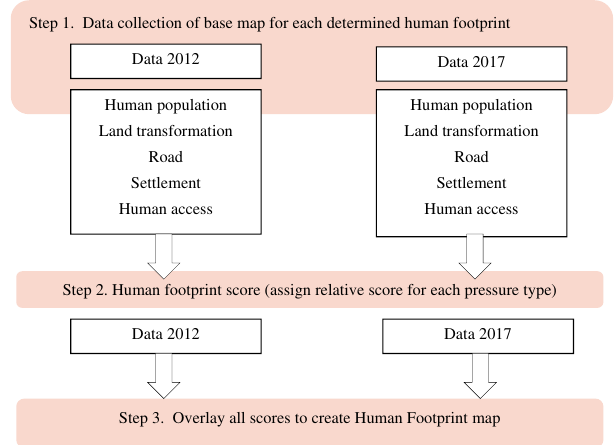
Figure 7. Flowchart showing the process of mapping the Human Footprint in 43 terrestrial national parks in Indonesia and in a 10-km buffer surrounding them. The steps detailed were slightly modified from the original 70 .